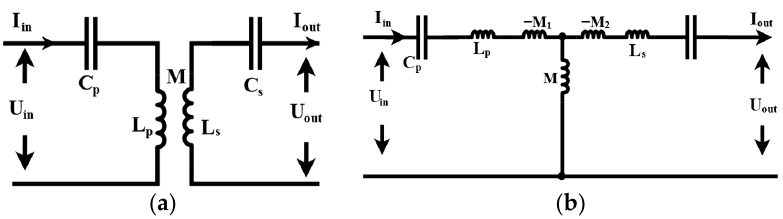
Figure 3. ( a ) S-S resonant compensation topology, ( b ) Equivalent circuit for S-S topology. The relationship between its compensation capacitance and coil inductance is as follows.